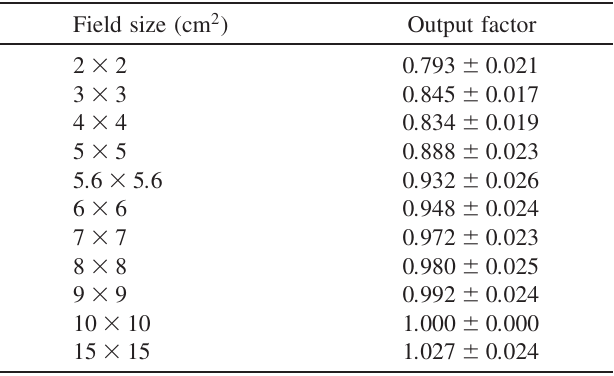
TABLE II. Output factor in the slab phantom given by square fields. These data are represented in Fig. 9.